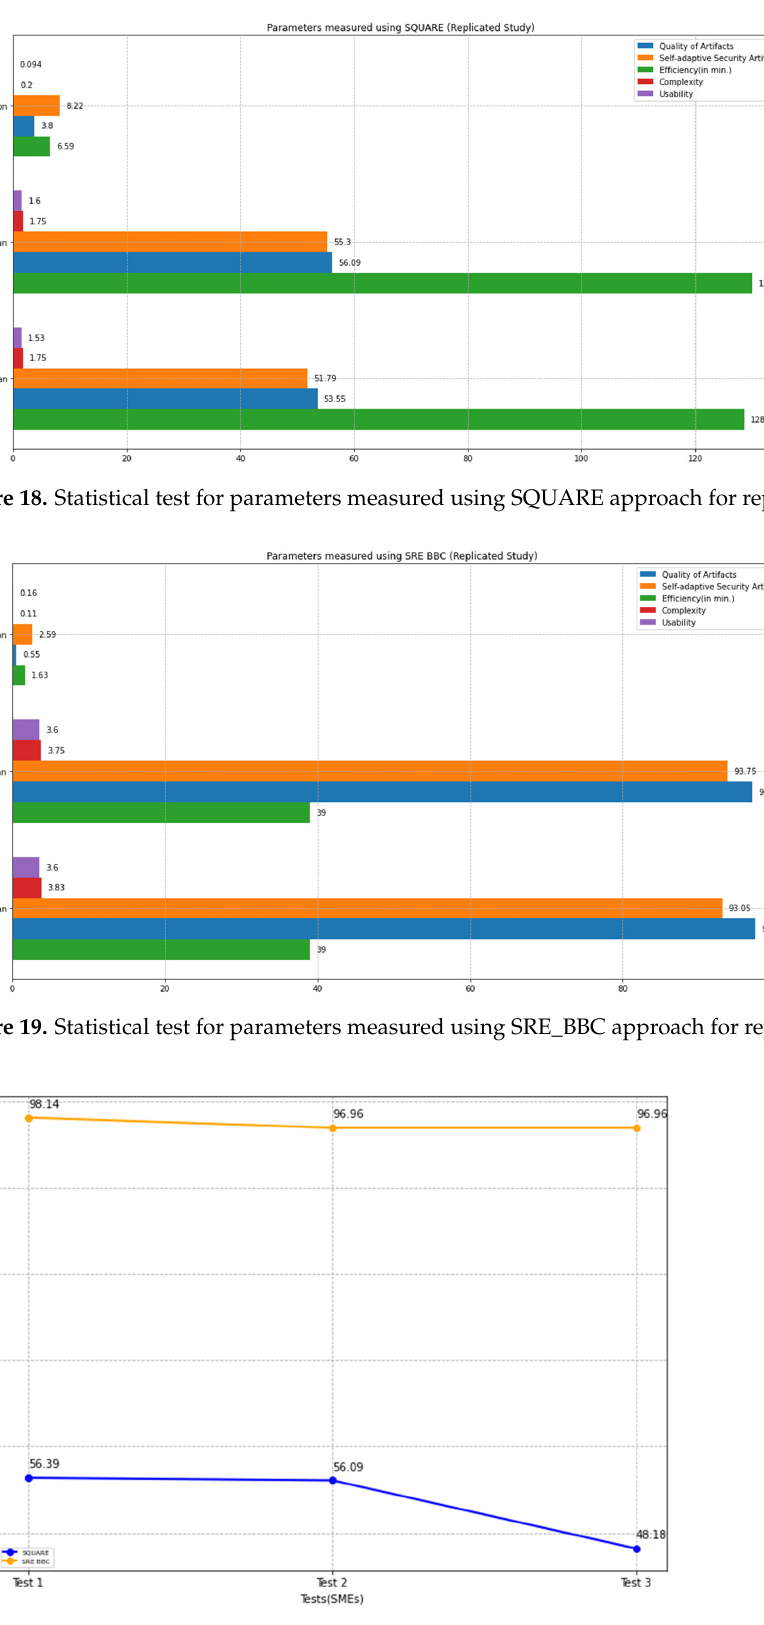
Figure 20. The comparison of quantified average artifact quality for SQUARE and SRE_BBC (Repli- cated